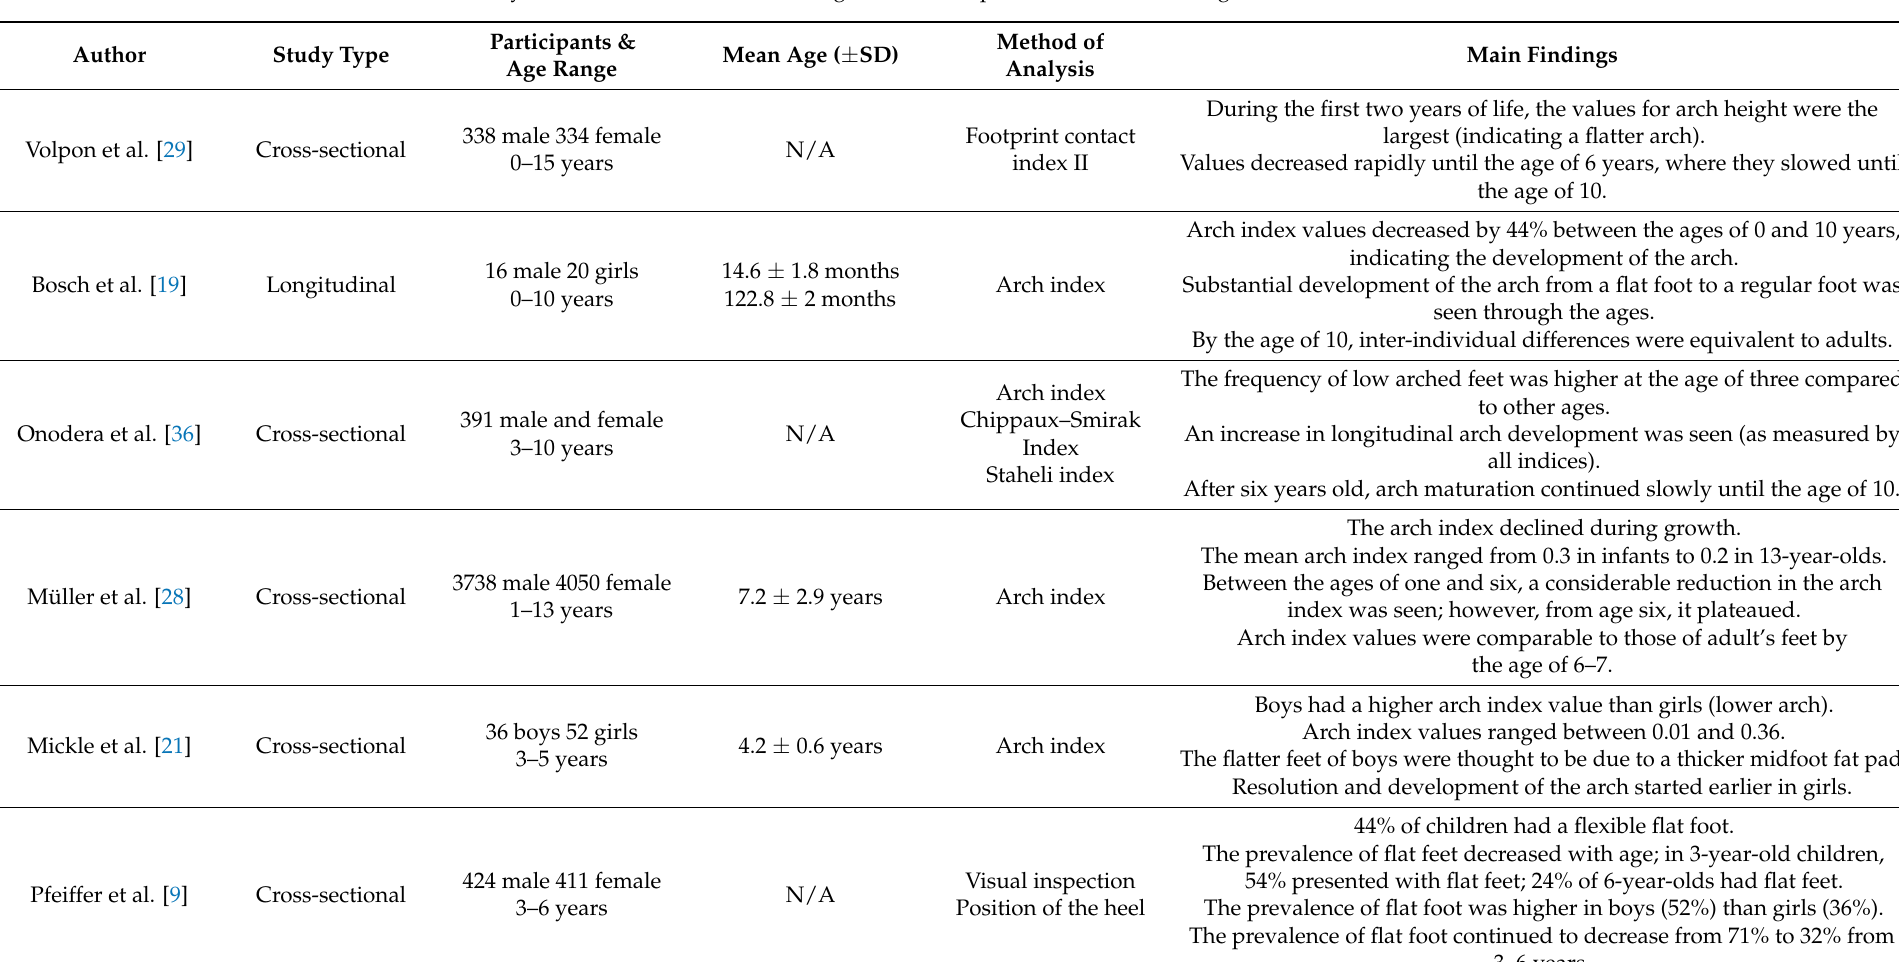
Table 3. A summary of the studies examined relating to the development of the medial longitudinal